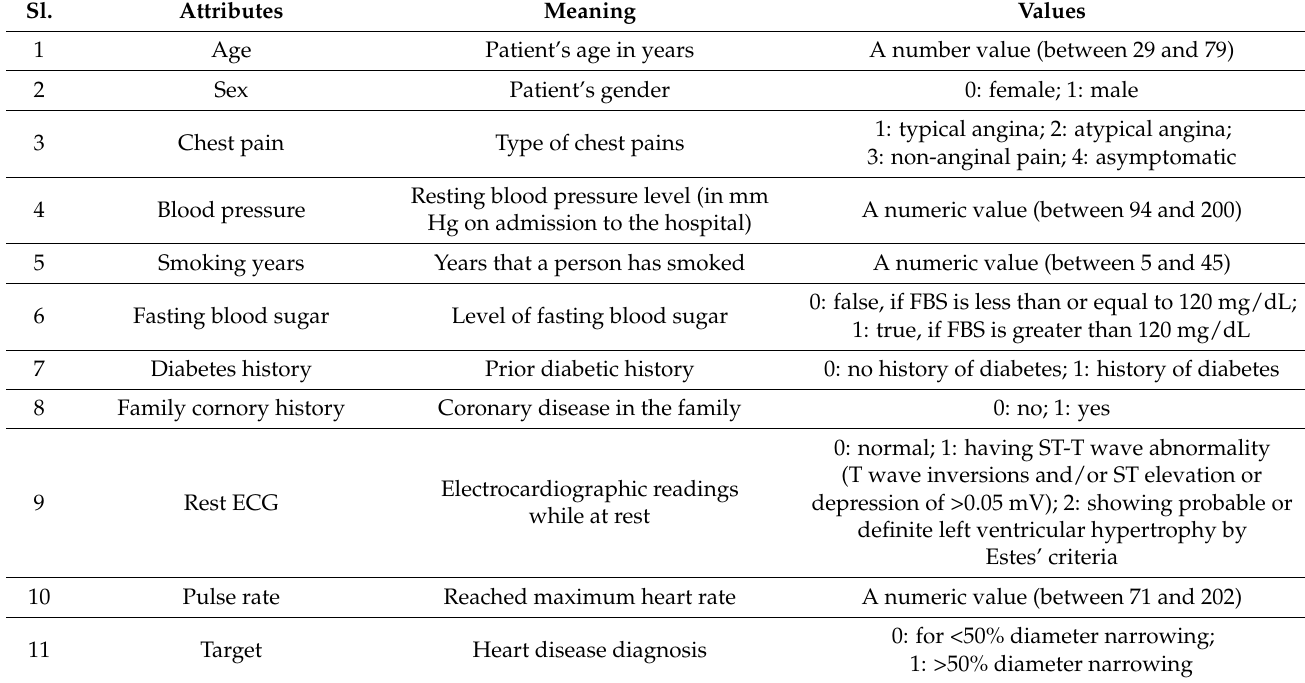
Table 3. Short description of attributes of IHDD